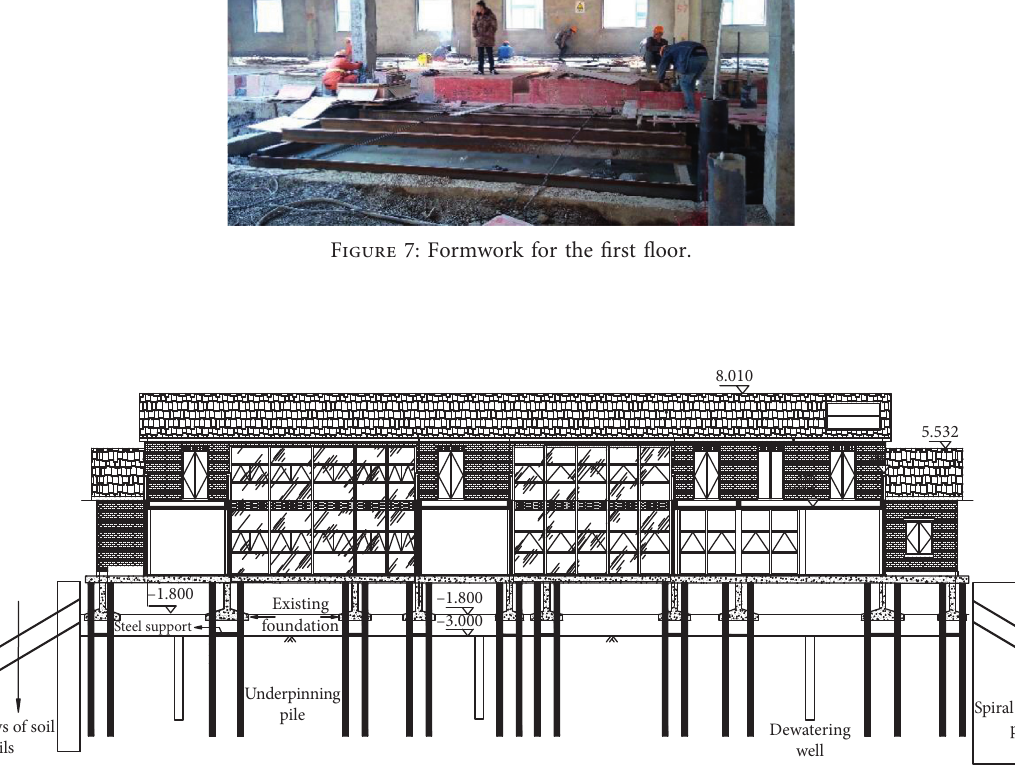
Figure 8: Excavating the second soil layer.